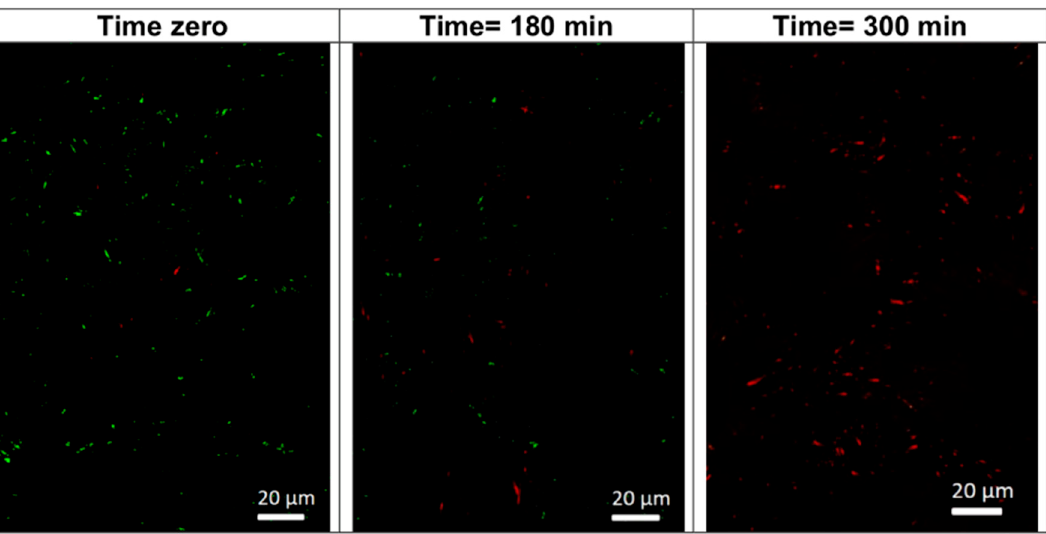
Figure 8. E. coli inactivation on ceramic tiles under low intensity solar light (50 mW/cm 2 ). 3.6. Interfacial Potential and Micro-pH at the Tiles’ Surface under Low Intensity Solar Simulated Light (50 mW/cm 2